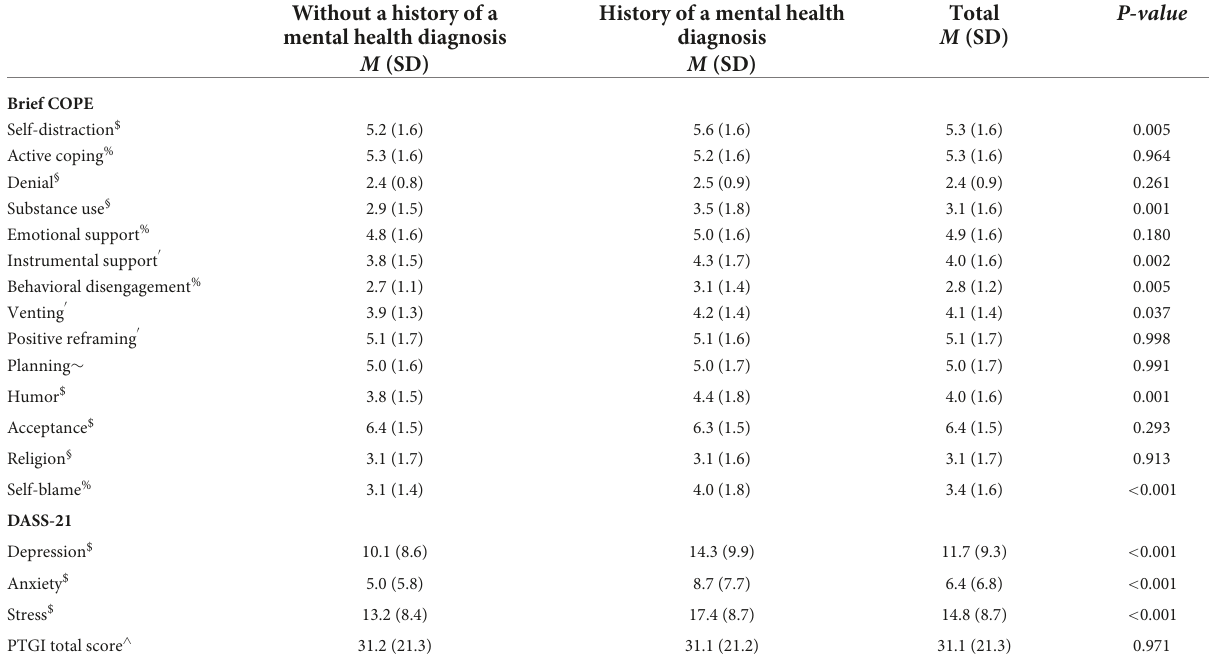
TABLE 2 Mean (SD) scores for the Brief COPE, DASS-21, and PGTI among the total sample and those with and without history of mental disorder. Without a history of a History of a mental health mental health diagnosis